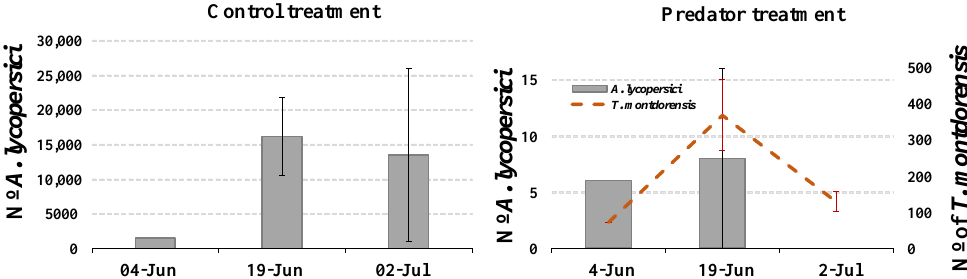
Figure 1. Number of A. lycopersici and number of predators per plant in the control and in the predator treatment. Scores were obtained via three destructive plant-washing samplings; the density of the collected mites was measured using a stereomicroscope (25×).